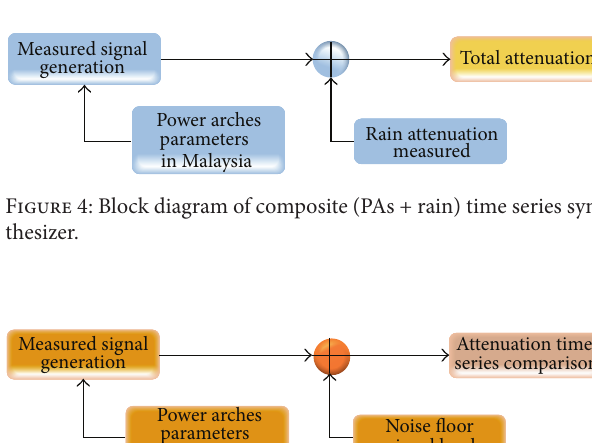
Figure 3: Different types of obstacles: trees, buildings, bridges, and tunnels.